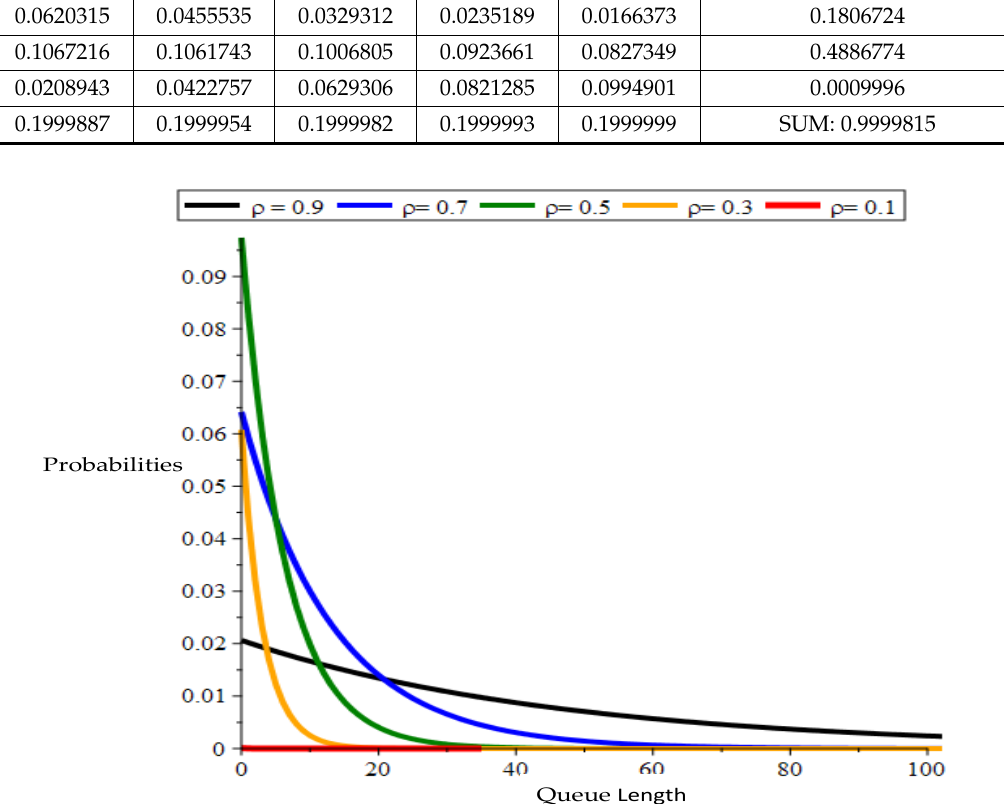
Figure 1. Comparison of performance measures of D/M 4,10 /5 for busy servers, ρ = 0.1, 0.3, 0.5, 0.7, 0.9, ε = 10 − 20